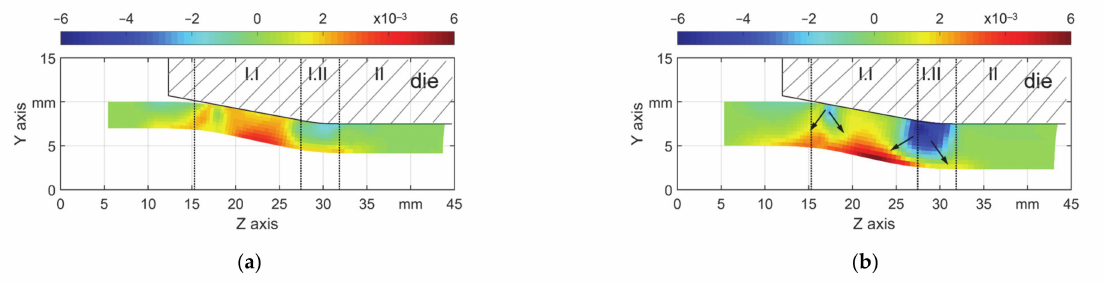
Figure 14. Radial plastic strain field ( ∆ PE y ) for µ = 0.18, ( a ) s 0 = 3 mm and ( b ) s 0 = 5 mm. To have a quantitative view, the distribution of ∆ PE y (radial direction) on the three featured layers, outer and inner surface and middle, are shown in Figure 15a,b. The values on the other layers were in the same range as in those three layers. The material on the outer surface and nearby experienced cyclic loading: compression, stretching, and again compression. The middle layer experienced much less cyclic loading, whereas the material in the inner surface only got stretched. Due to the stress concentration around z = 17 and 30 mm, the summation of radial ∆ PE y values at those locations show the lowest local values for all of the tubes, which indicates the lowest increase of the wall thickness (Figure 15a) for T3 and decrease of the wall thickness (Figure 15b) for T5. This explains the second feature in Chapter 3.1 that the wall thickness at the beginning of reduction zone and in the transition zone shows a less increment for T3 (Figure 9a) and an obvious reduction for T5 (Figure 9b).